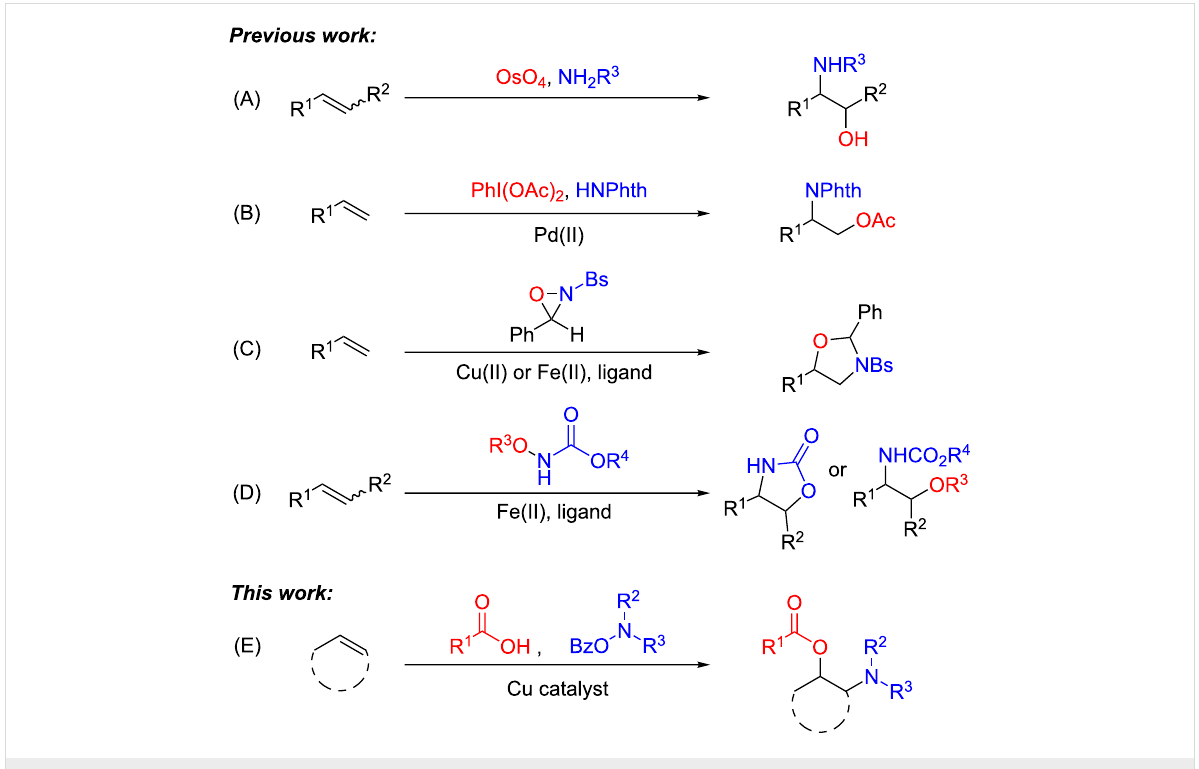
Scheme 1: Strategies for intermolecular olefin oxyamination.